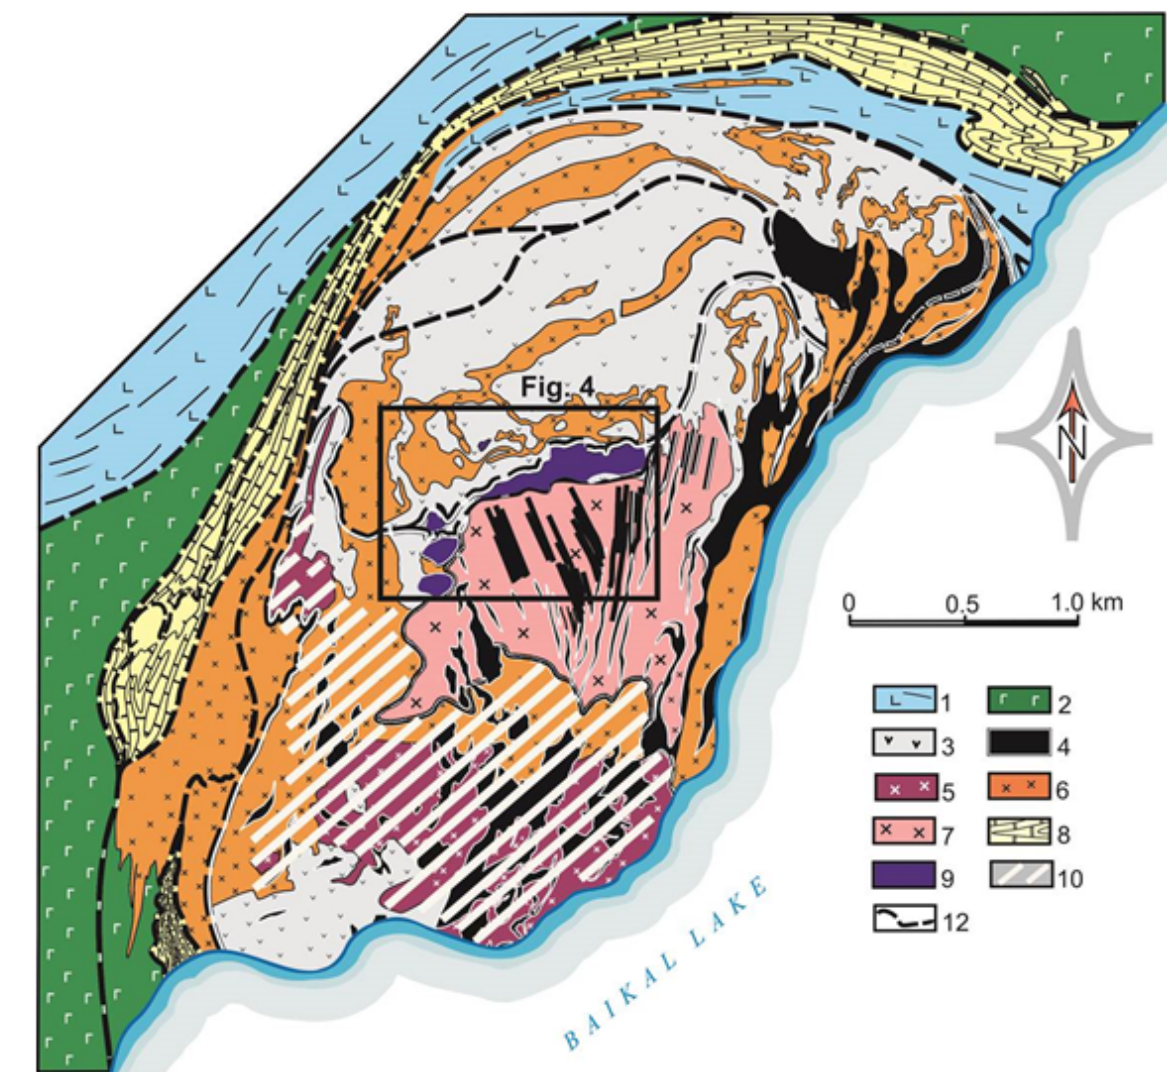
Figure 3. Simplified geology of Tazheran Massif, modified after [14,23]: 1–2 = country rocks, 500 Ma: amphibolite, silicate– carbonate gneiss (1); metamorphosed gabbro, monzogabbro, monzonite, and syenite (2); 3–7 = Tazheran Massif, 460–470 Ma: beerbachite after tholeiitic dolerite and gabbro (3), subalkaline gabbro and microgabbro (4), nepheline syenite (5), foliated (6) and massive (7) syenites; 8–10 = calcic (8), alkaline (9), and magnesian (10) metasomatic rocks; 11 = synmetamorphic ductile detachment; 12 = geological boundaries. You can view “Image” in Figure 4.